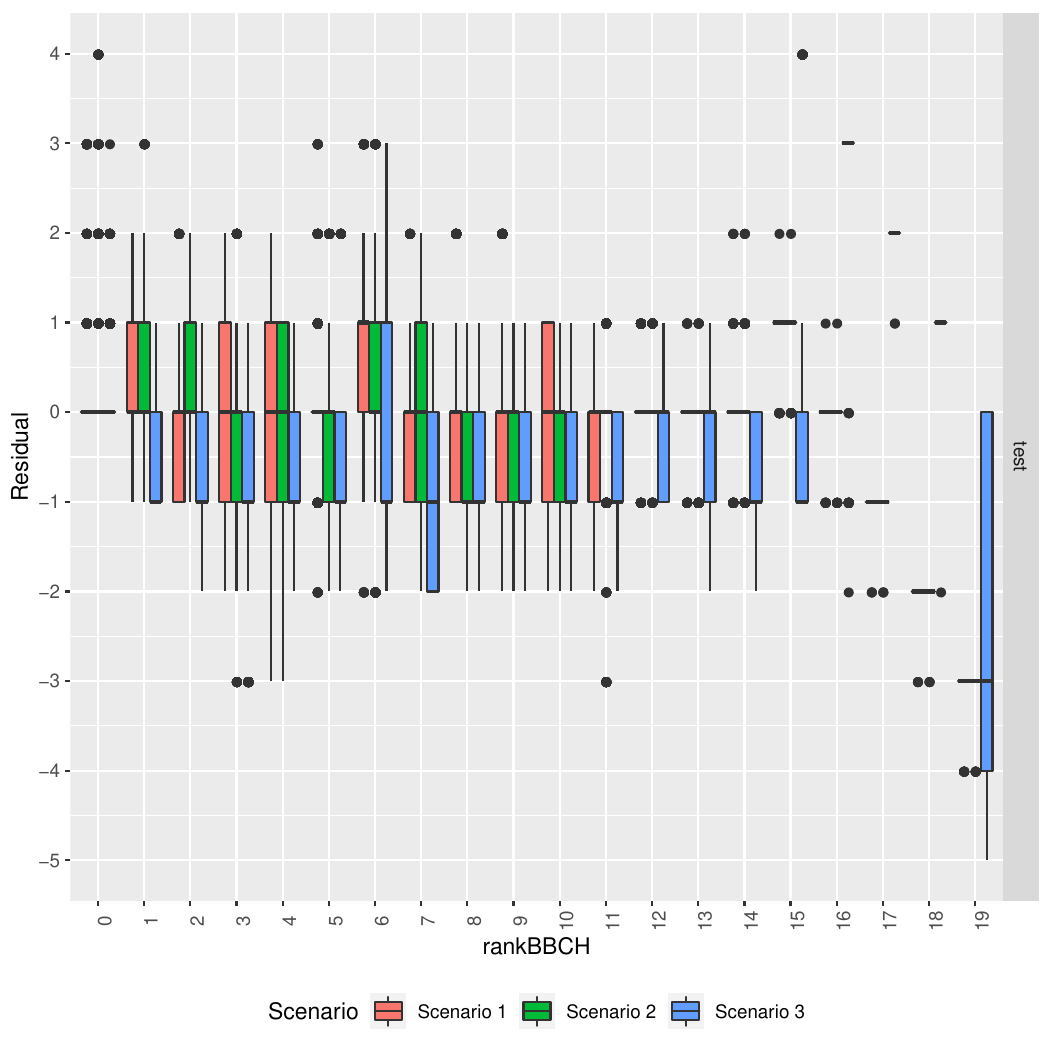
Figure 12. Comparison of the residuals by target output for the different models’ in the scenarios described in Table